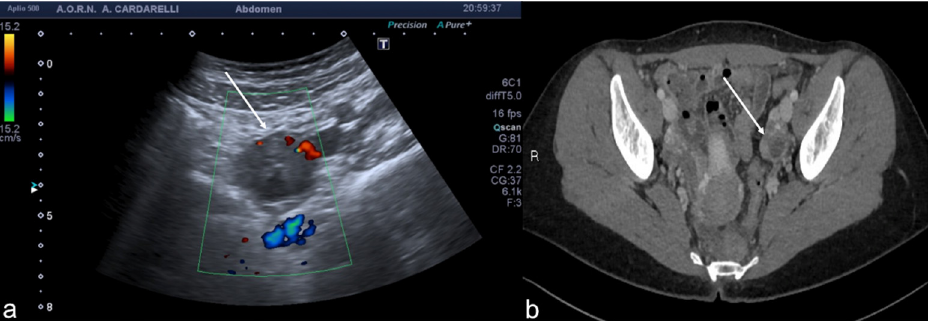
Figure 5. Pelvic inflammatory disease. US scan of the right adnexa ( a ) shows an anechoic oblong structure (( a ), caliper). Contrast-enhanced axial CT image ( b ) and maximum intensity projection (MIP) coronal-oblique reconstruction ( c ) show tortuous and tubular fluid filled structure seen in the right adnexa (( b , c ) arrows).